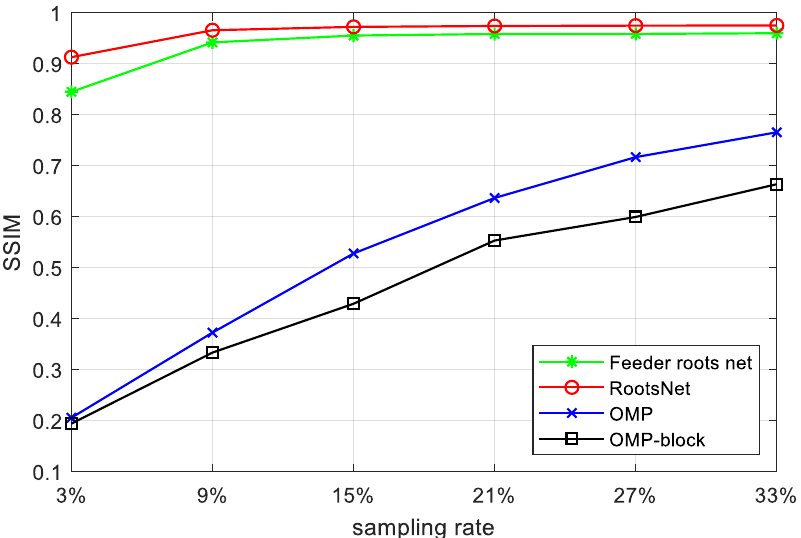
Figure 9. Imaging results on different specimens. ( a ) OMP with 33% of sampling rate; ( b ) Block OMP with 33% of sampling rate; ( c ) the proposed feeder root net output with 3% of sampling rate; ( d ) the final output of the proposed RootsNet with 3% of sampling rate; ( e ) the final output of the proposed RootsNet with 33% of sampling rate.